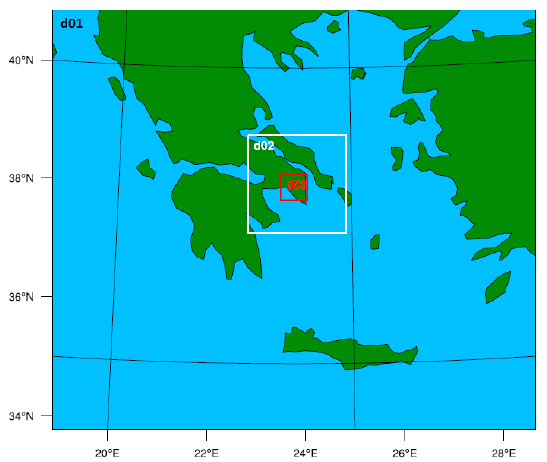
Figure 1. Nested computational domains used in the present study for the WRF numerical weather prediction implementation (map is from output of the WRF-WPS system) over Greece and the Greater Athens Area (GAA).